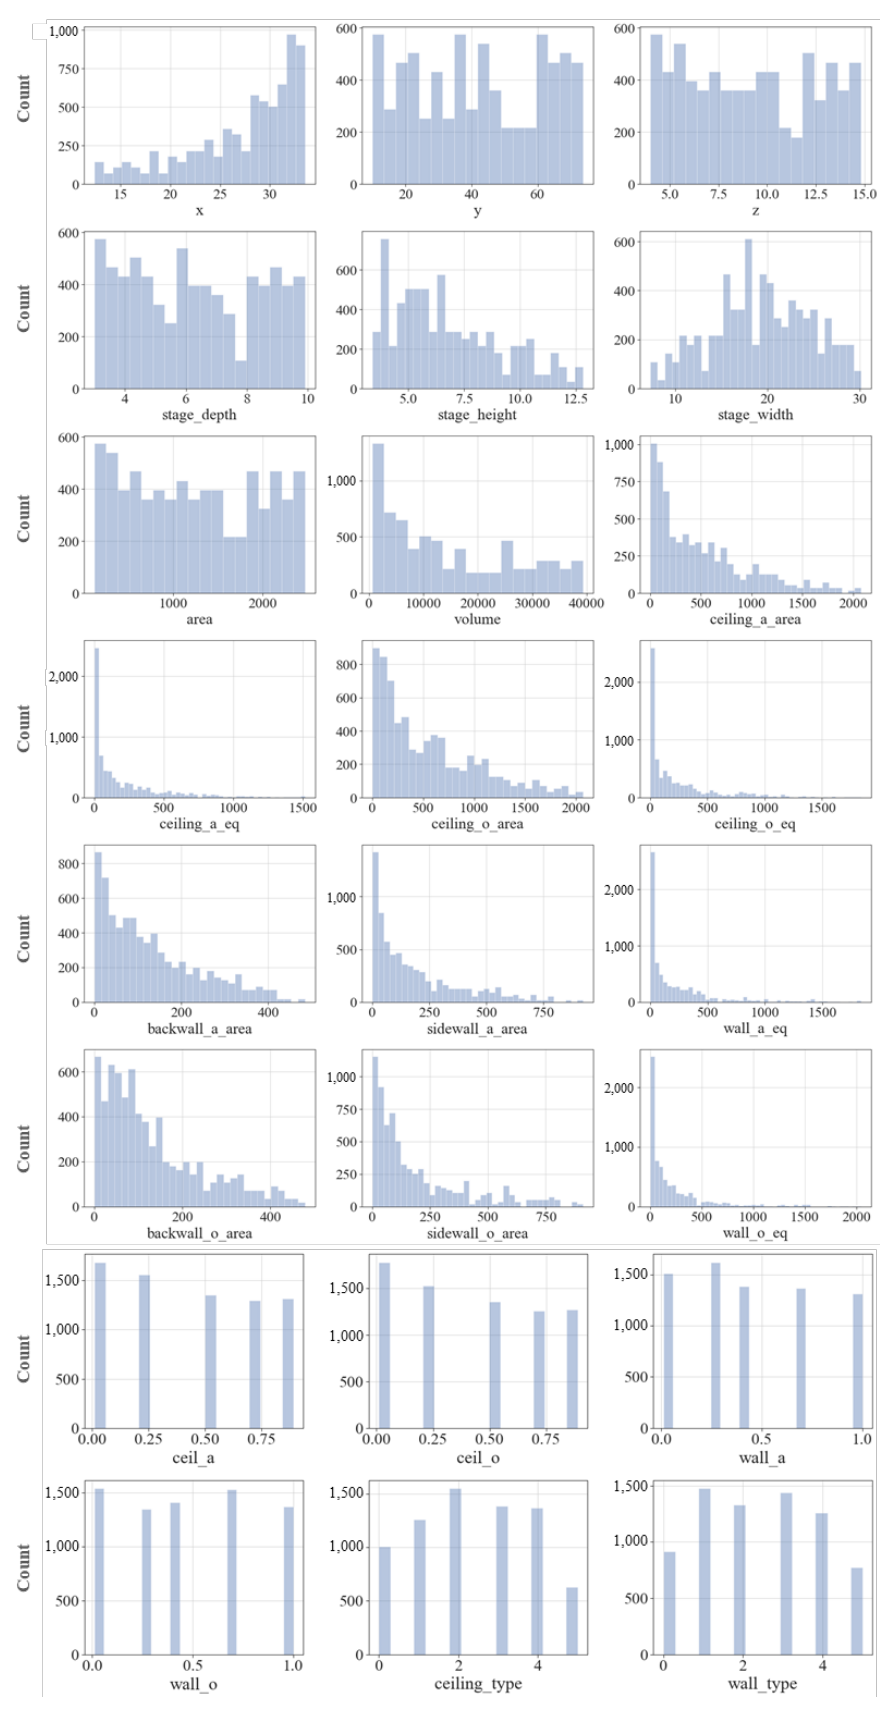
Figure 13. The distribution of features.